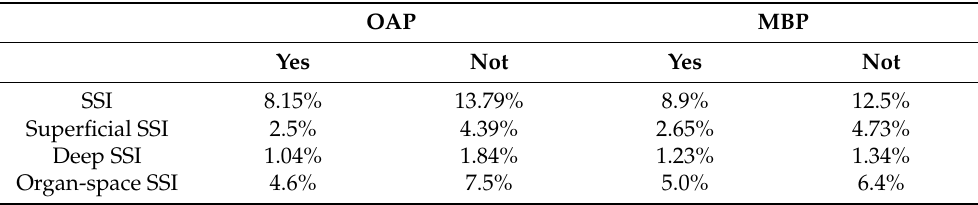
Table 4. SSI rates according to the use of OAP and MBP.